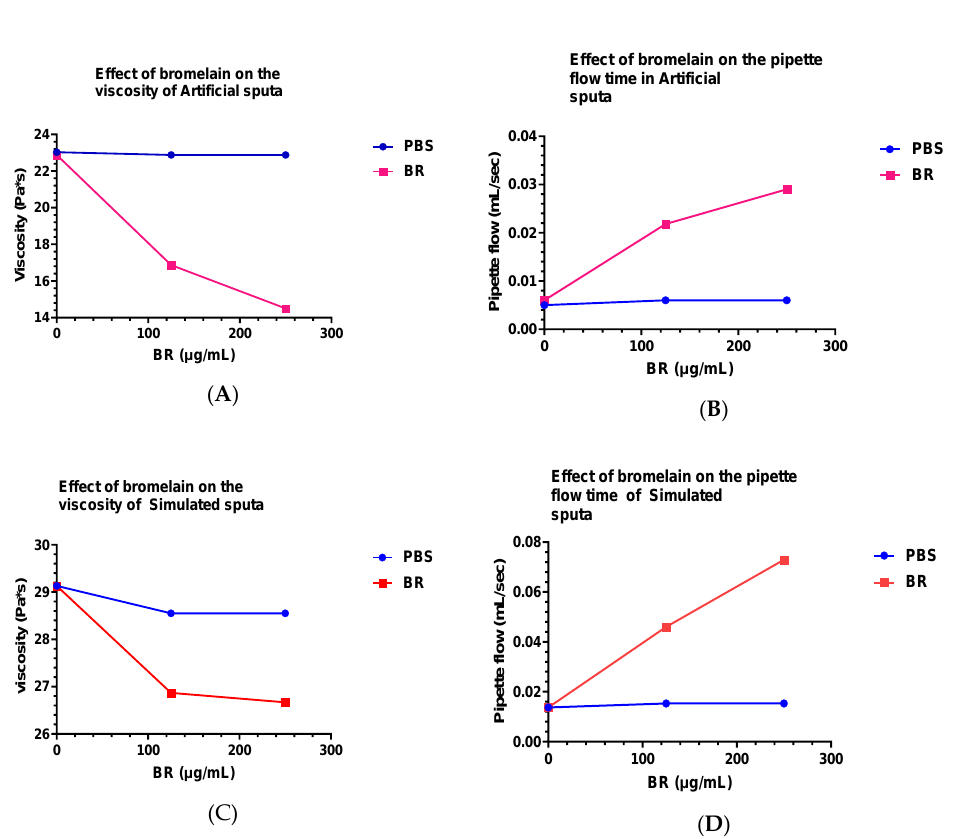
Figure 3. ( A ) In artificial sputum (AS), with the addition of bromelain (BR), there was a considerable reduction of viscosity in comparison to control (PBS). ( B ) The pipette flow in AS was considerably increased as compared to control (PBS) when treated with bromelain. ( C ) In simulated sputa (SS), the addition of bromelain shows a reduction in viscosity in comparison to control (PBS). ( D ) In SS, the pipette flow was highly increased compared to control (PBS) after treatment with